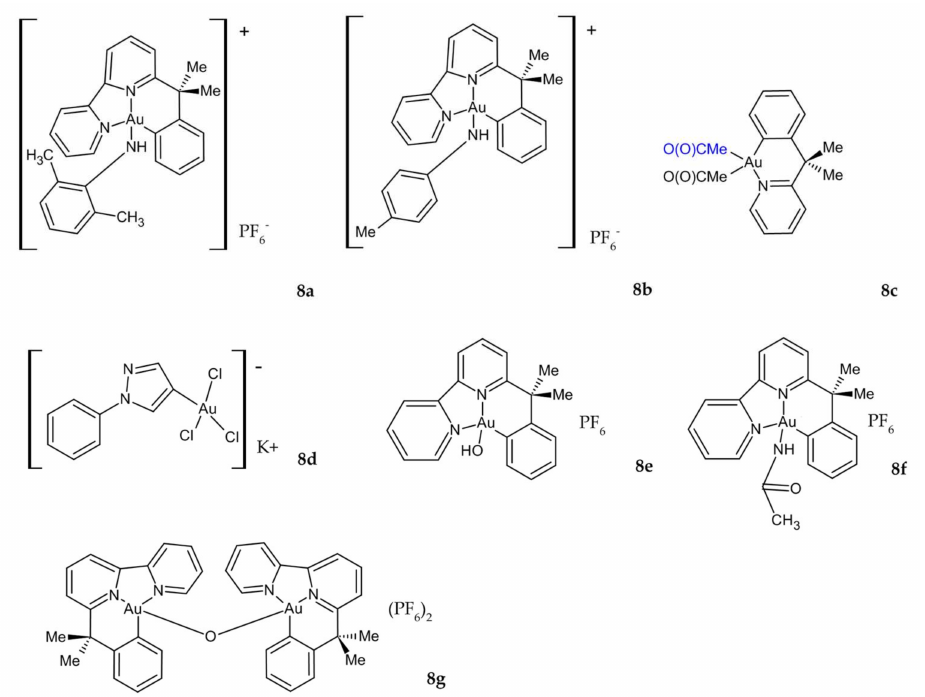
Figure 5. Novel organogold (III) compounds 8a – g